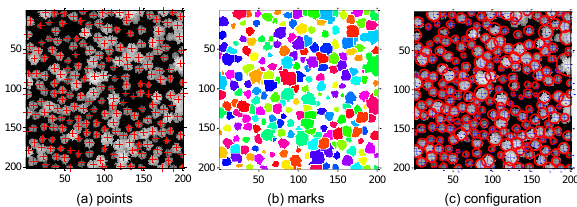
Figure 1: An example showing a configuration construction from a CHM. (a) a set of local maxima as potential tree positions; (b) segmentation of CHM to enable feature extraction; (c) generated configuration from the set of local maxima.